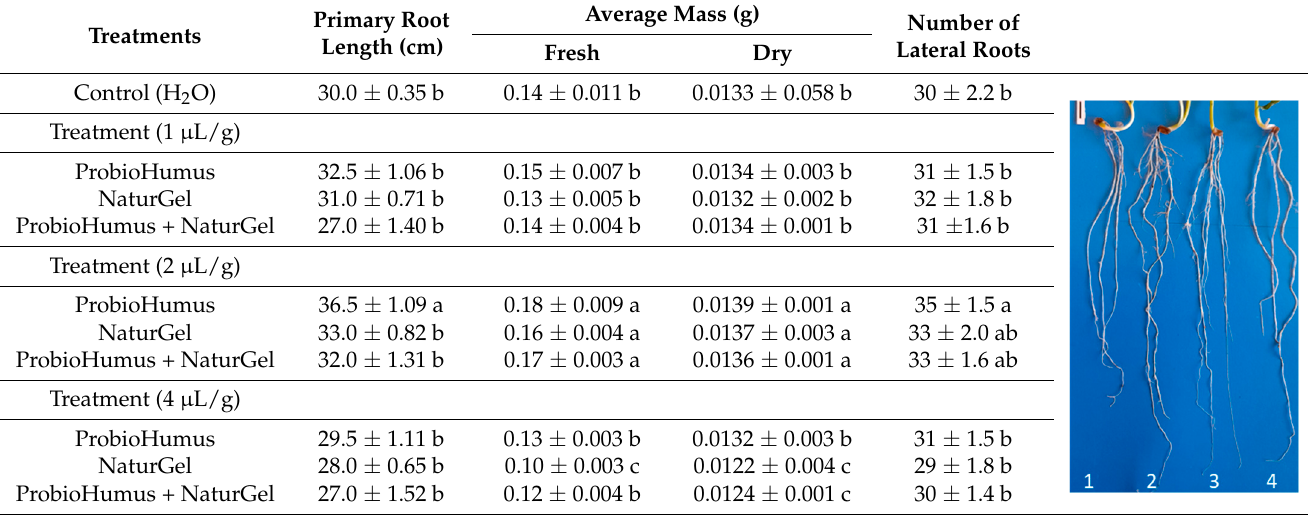
Table 1. Effect of seed priming with probiotics on wheat root morphometric parameters after 16 days of cultivation under controlled laboratory conditions. Photo shows the effect of the selected concentration of probiotics (2 µ L of probiotic on 1 g of seeds) on the development of wheat roots: 1. Control; 2. ProbioHumus; 3. NaturGel; 4. ProbioHumus + NaturGel.